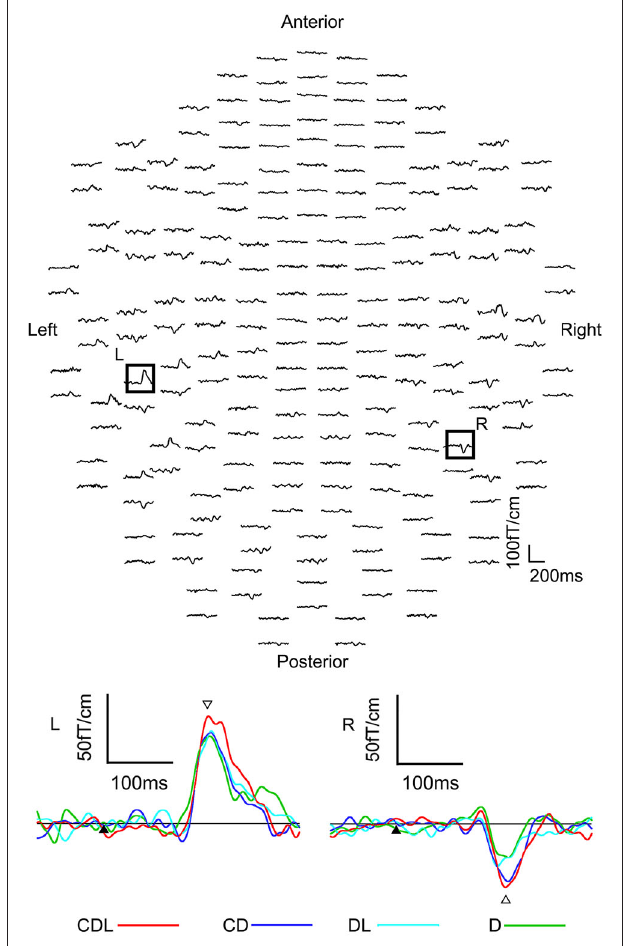
FIGURE 4 | The waveforms recorded from 204 gradiometers of a representative subject following the S2 onset (eye movements) in the CDL condition. R: representative waveforms at sensor R in the right hemisphere of the upper image. L: representative waveforms at sensor L in the left of the upper image. Black arrows are the S2 onset. White arrows indicates the main response after the S2 onset (adopted from Miki et al.,